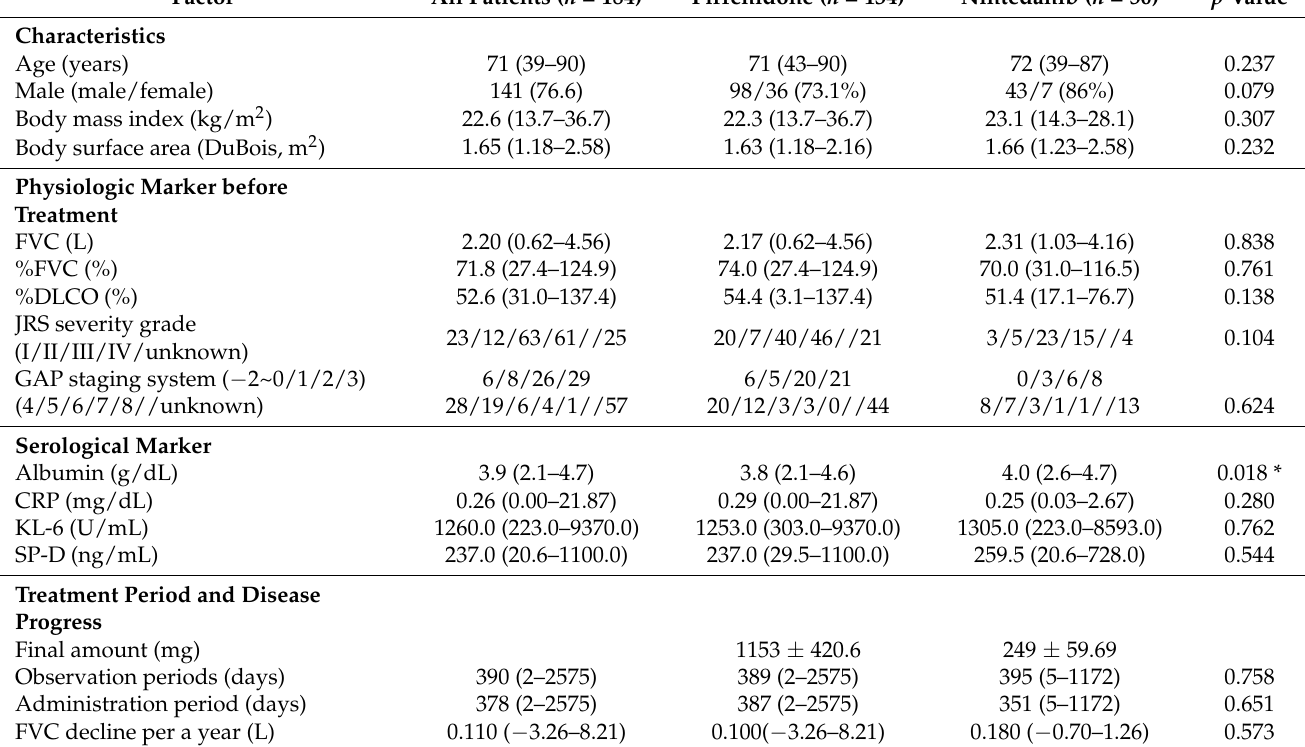
Table 1. Background and treatment of all patients.